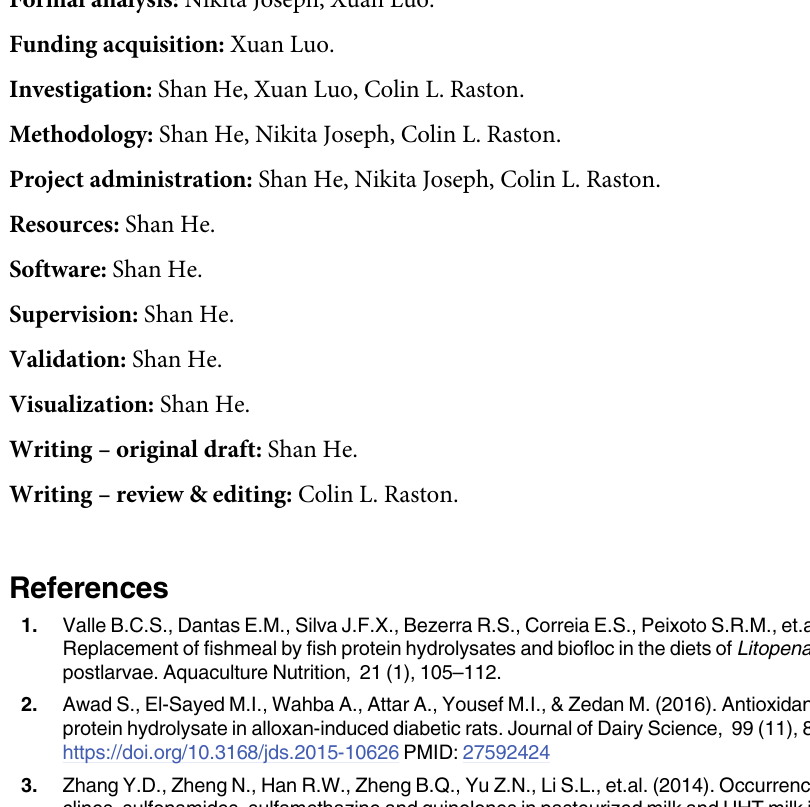
S3 Fig. Dynamic light scattering (DLS) data for preparing encapsulated particles using a vortex fluidic device (VFD) operating at different flow rates, for a fixed tilt angle and rota- tion speed. (DOCX) S4 Fig. Dynamic light scattering (DLS) data for preparing encapsulated particles using a vortex fluidic device (VFD) operating at different tilt angles, with a fixed tilt angle and dif- ferent flow rates.